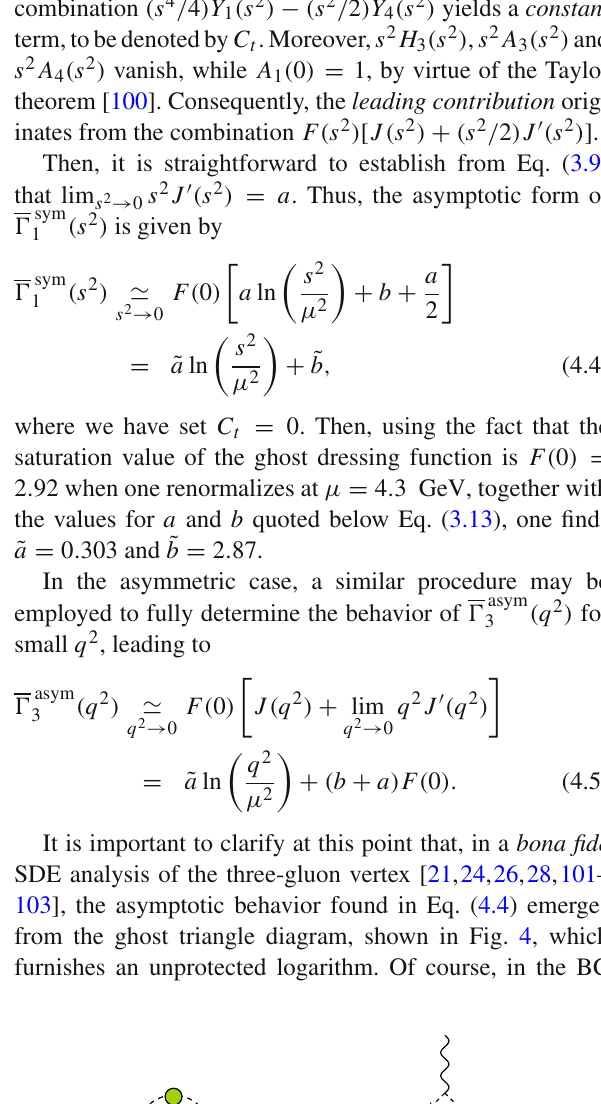
given in Eqs. (3.8) and (3.9). In the last column, we quote the momen- tum q ∗ ,wheretheminimumof (cid:5) − 1 ( q 2 ) [ormaximumof (cid:5)( q 2 ) ]occurs